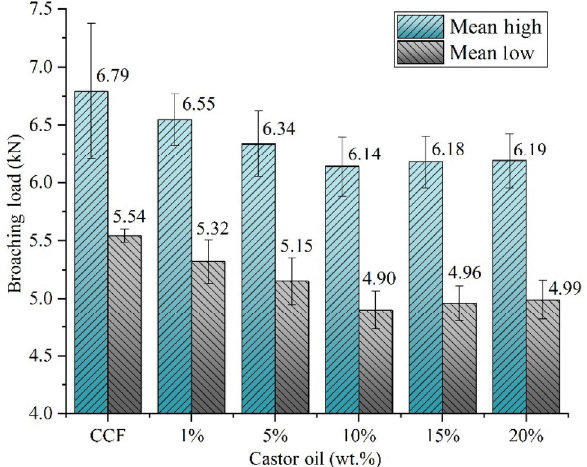
Fig. 3 Broaching load for different concentrations of castor oil in the W-O cutting fluid.